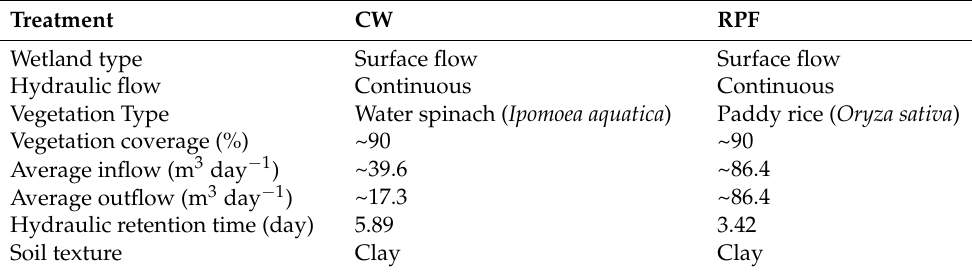
Table 2. General characteristics of CW and RPF